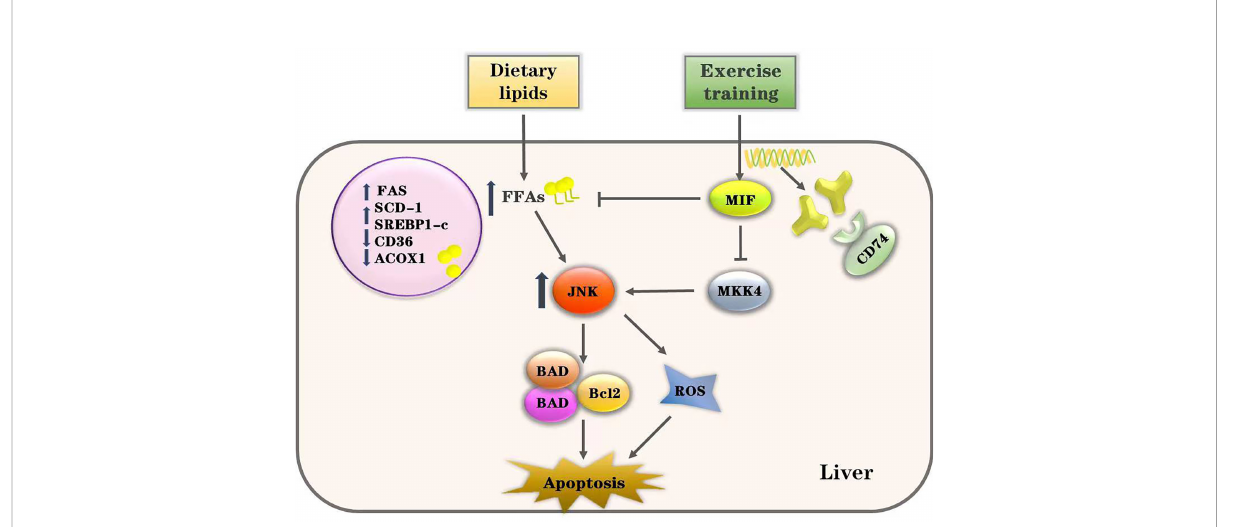
FIGURE 8 Proposed pathway of exercise ’ s effects on HFD-induced lipotoxicity. Excessive intake of dietary lipids induced metabolic disorders of free fatty acids (FFAs) and induced the activation of JNK-mediated apoptosis in the liver. However, our data show that exercise training alleviates hepatic lipotoxicity and suppresses the JNK pathway through enhancing MIF signaling. Thus, we conclude that exercise inhibits JNK pathway activation and lipotoxicity via MIF in